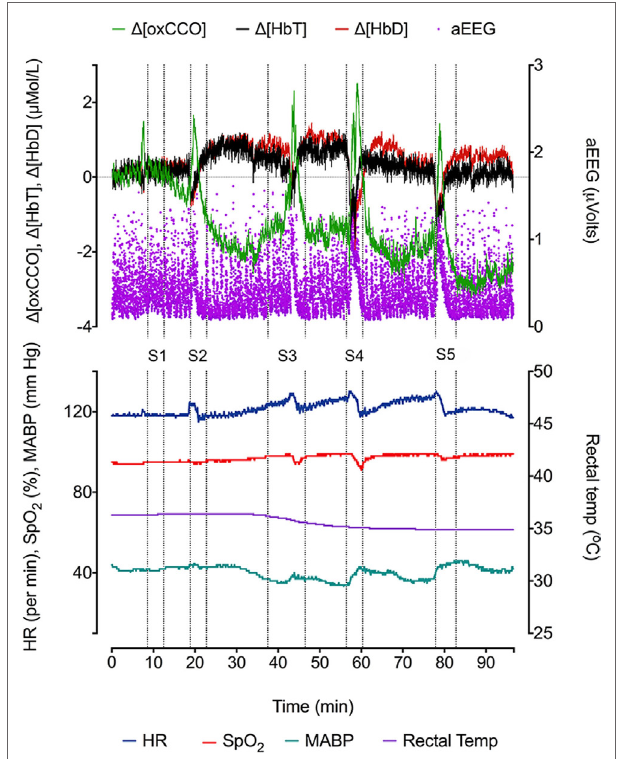
FIGURe 2 | Changes in NIRs variables ( Δ [HbD], Δ [Hbt], and Δ [oxCCo]), aeeG (F3–C3), and systemic parameters [heart rate (HR), peripheral oxygen saturation (spo 2 ), mean blood pressure (Bp mean), and rectal temperature (°C)] during five recurrent seizure episodes (s1, s2, s3, s4, and s5)